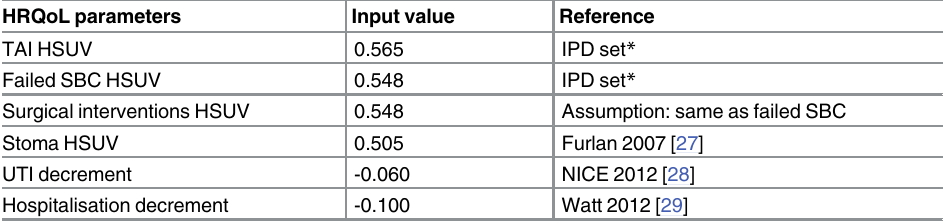
Table 3. Health State Utility Values (HSUV).